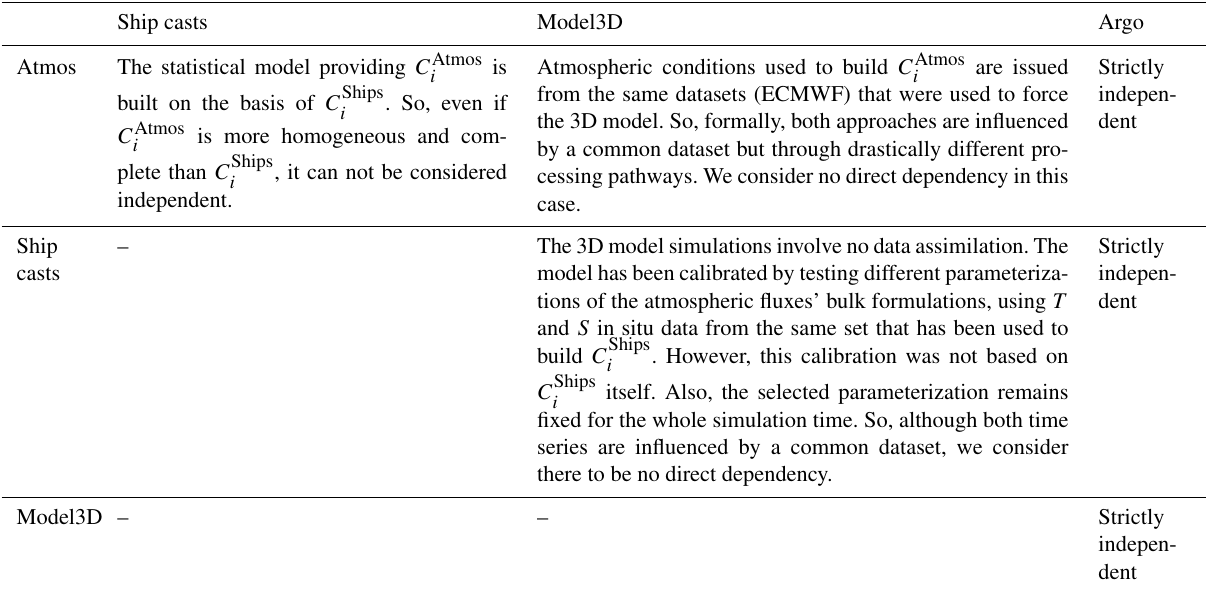
Table A1. Dependence relationships between the different